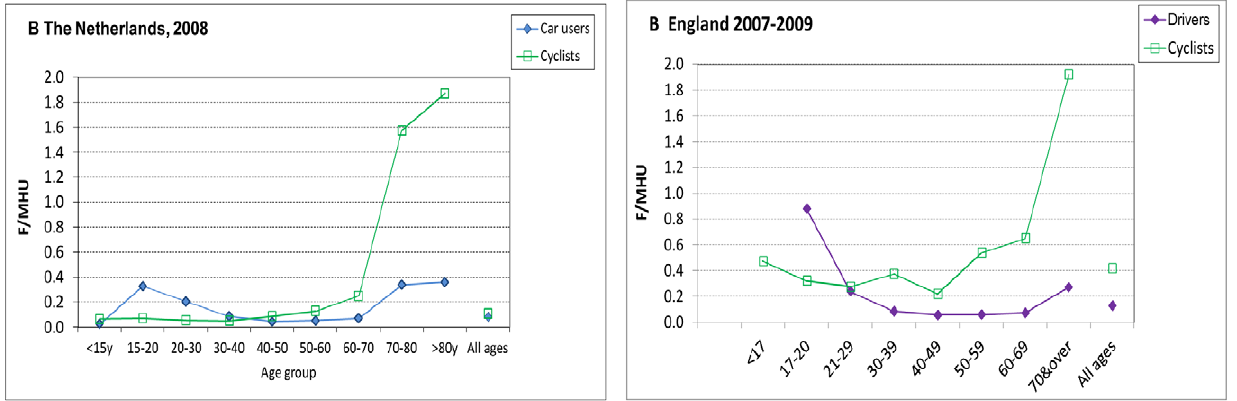
Figure 3. Fatality rates per million hours’ use in the Netherlands and England, by age. a. The Netherlands, 2008. b. England, 2007–2009. There are a number of limitations to these comparisons. First, data for the two countries use slightly different age-groups. Due to inaccuracies in driving data for those below the legal limit for driving, data for the youngest groups are not shown, although they are included in the ‘all ages’ categories. Secondly, fatality rates for the Netherlands are for all car occupants whereas for England they are restricted to drivers (plus small numbers of fatalities for unspecified car occupants), with passengers excluded from both the numerator and denominator. Thus the age-specific rates for the Netherlands underestimate the variability in rate by age of driver. Thirdly, the data shown are the actual ‘all persons’ data from the two countries. Therefore, the English data for cyclists are weighted to the figures for males. English males cycled four times the distance but had six times as many fatalities as women, and spent twice as much time driving as women but had three times as many deaths. For the Netherlands, driving is similarly dominated by males, but cycling distance is equally split between males and females.